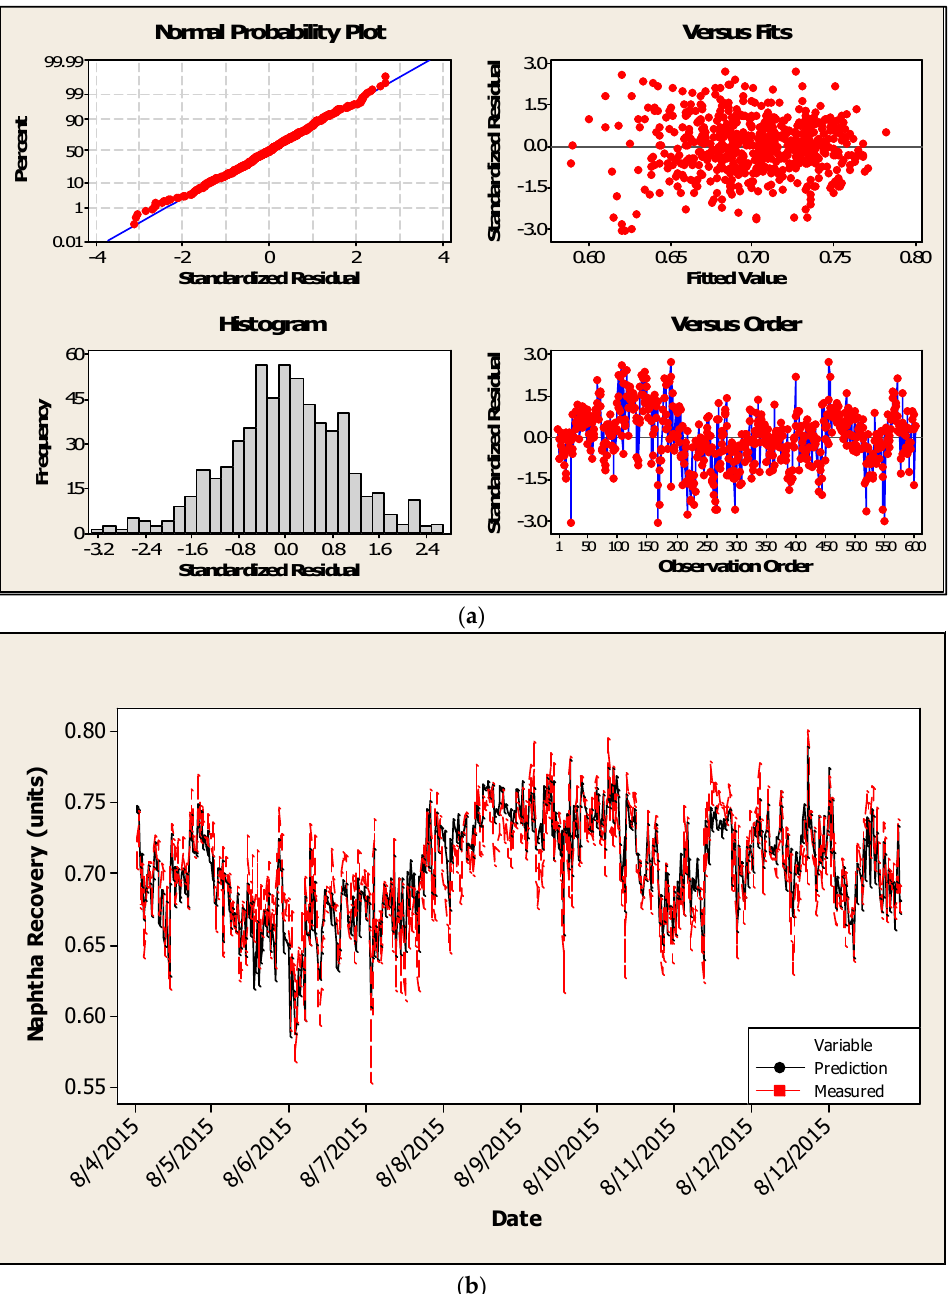
Figure 5. ( a ) Statistical modelling results for OP2 (residuals developed using training data); ( b ) Statistical modelling results for OP2 comparing measured versus predicted NR using testing data.